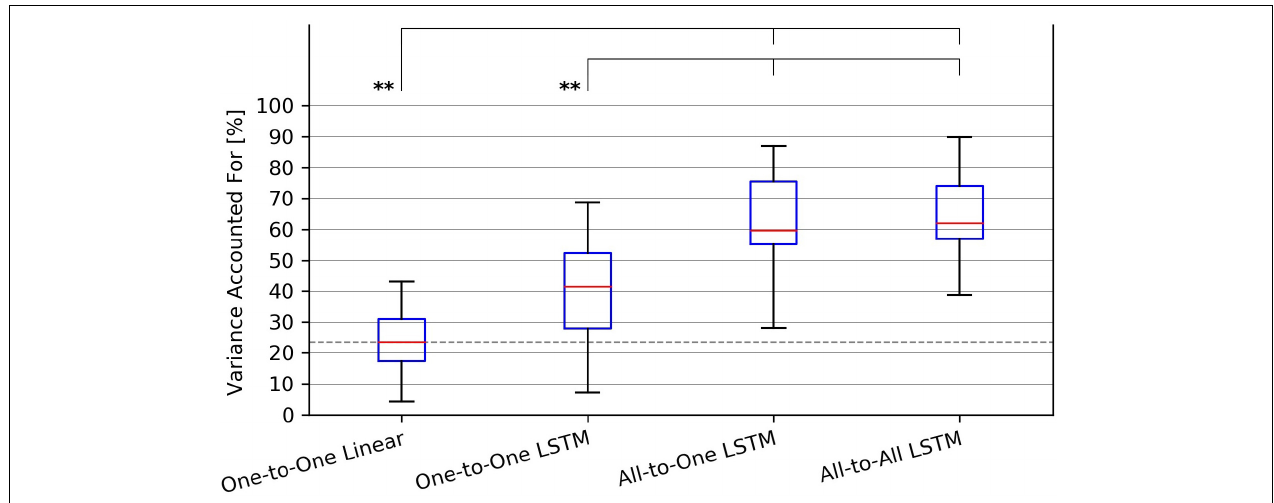
FIGURE 4 | Tukey box plot of Variance Accounted For (VAF) metrics achieved by all evaluated force regression methods. Whiskers extend 1.5 interquartile ranges below and above the first and third quartile, respectively. ** p < 0 . 01.